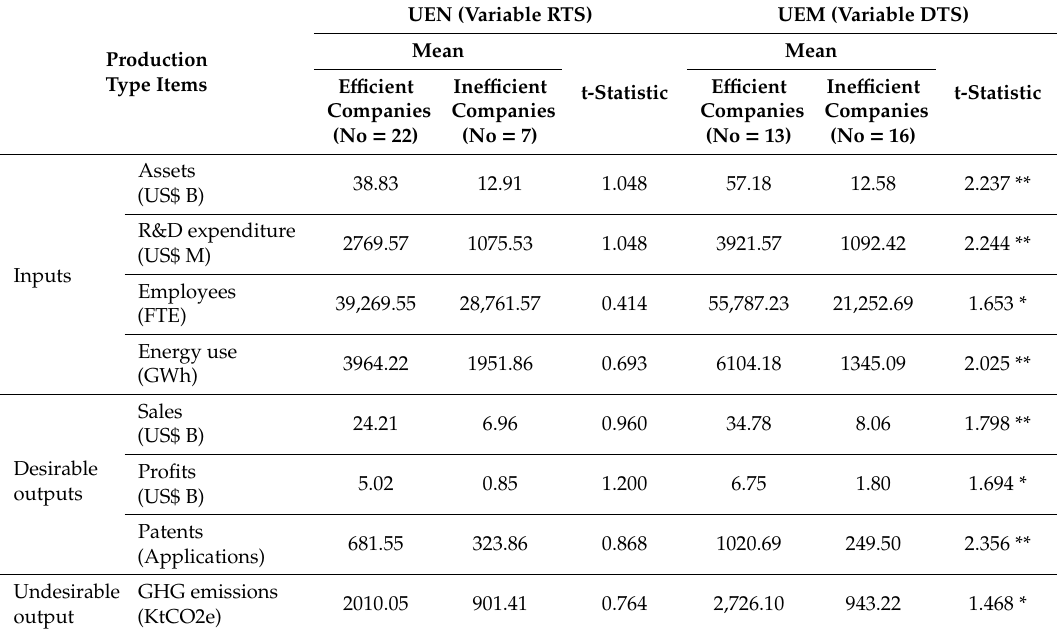
Table 6. Mean test ( t -test) between unified e ffi cient and ine ffi cient firm